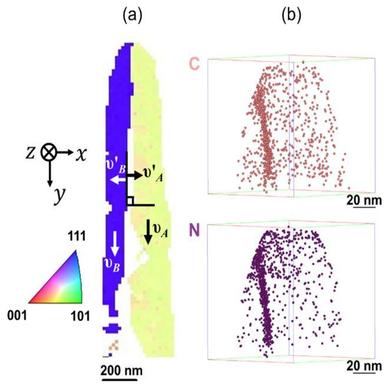
(a) TKD map of multicrystalline silicon specimen that contains a grain boundary. (b) Atom maps showing the segregation of carbon and nitrogen to the grain boundary.